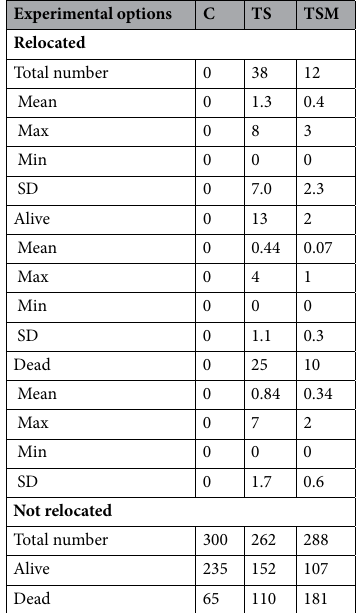
Table 1. Total number of tardigrades relocated out of the square and not relocated, alive and died for each experimental option (total number of tardigrades for each experimental option was 300): C—control; TS— snail + tardigrades; TSM—snail + tardigrades + moss. Standard deviation (SD) and mean (Mean) given for relocated tardigrades as well as minimum (Min), and maximum (Max) number of transferred tardigrades per